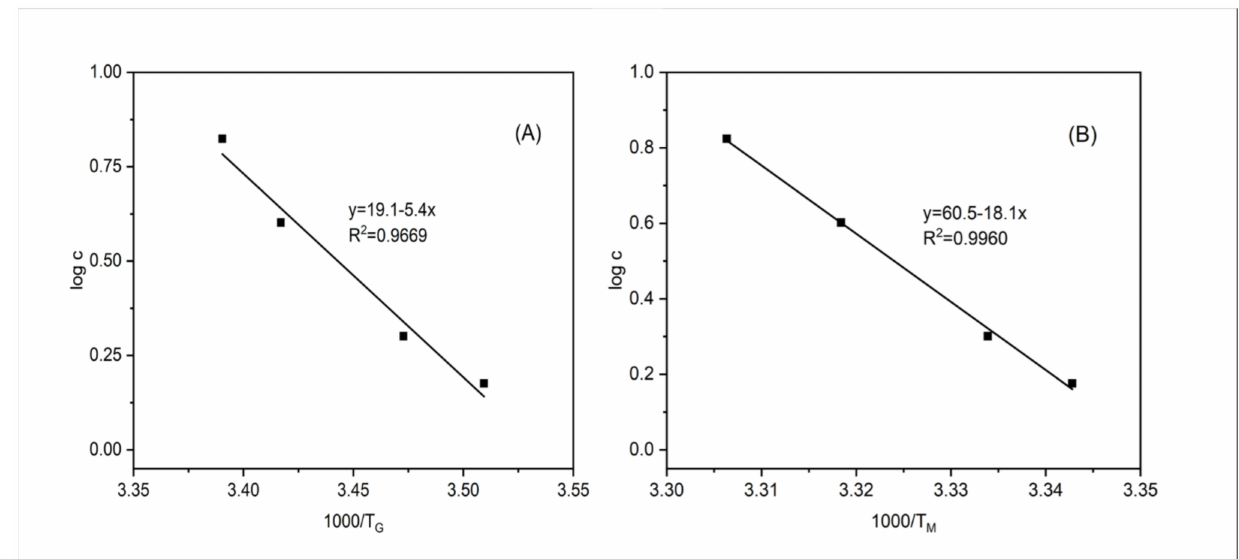
Figure 8. The relationship between the logarithm of gelatin concentration and T G ( A ), T M ( B